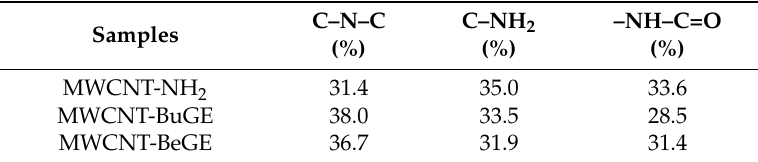
Table 1. N1s peak area of MWCNT-NH 2 , MWCNT-BuGE and MWCNT-BeGE.